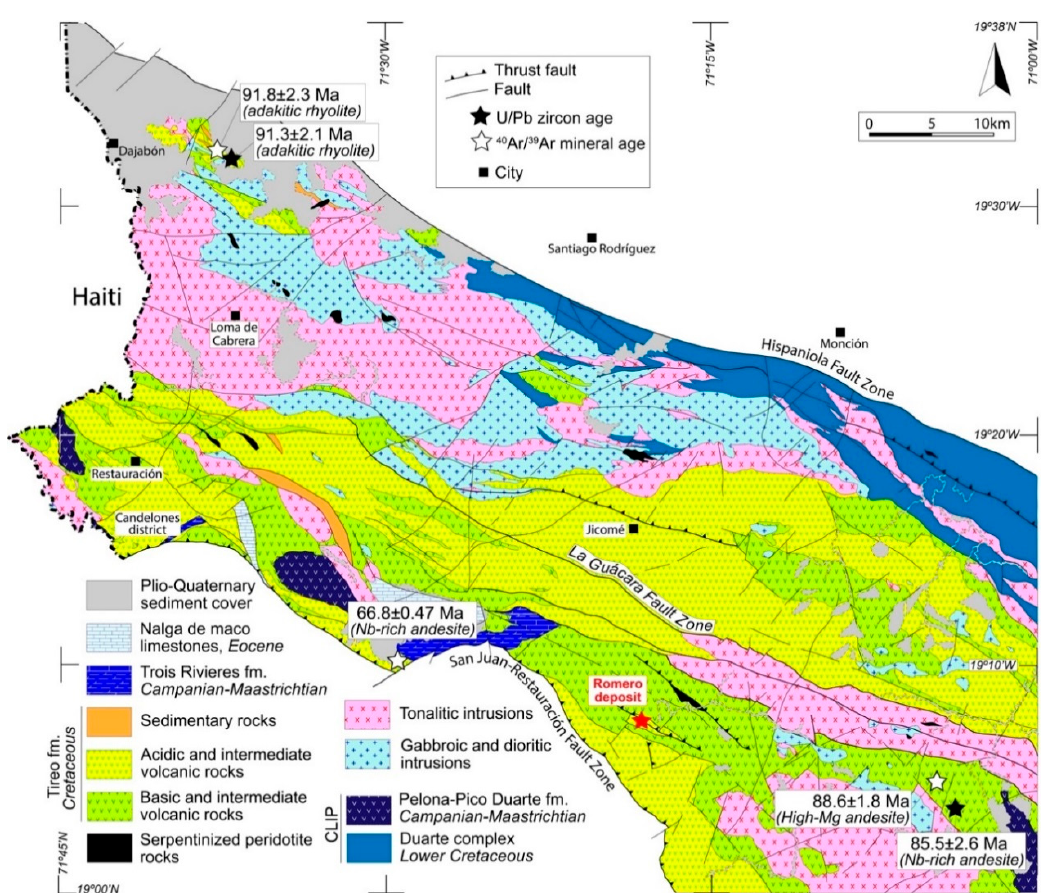
Figure 2. Geologic map of the NW Cordillera Central of the Dominican Republic showing the geologic units comprised fault zones between the Hispaniola and the San José-Restauración. The location of the Romero deposit is indicated with a red star. The U/Pb and 40 Ar/ 39 Ar ages are after Escuder-Viruete et al. [47].